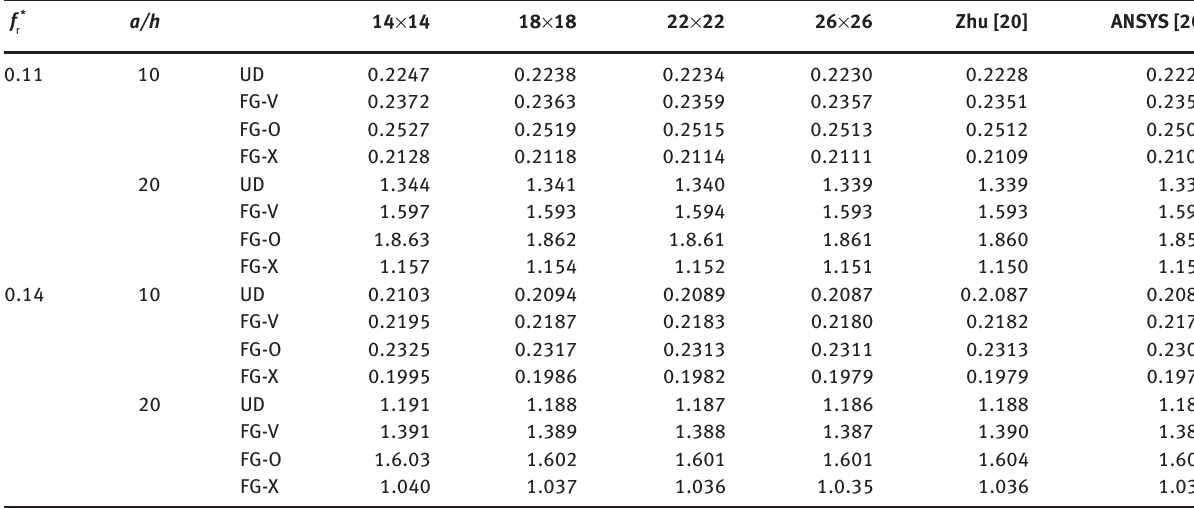
Table 3 Convergence and accuracy of dimensionless central deflection for a clamped square CNTRC plate subjected to